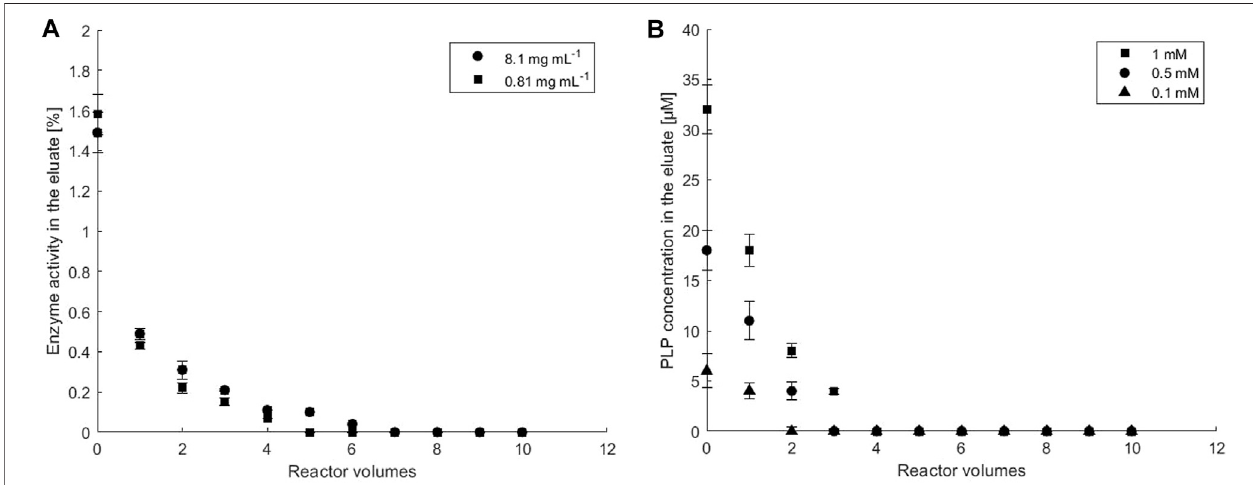
FIGURE 3 | The stability of ATA-v1 and PLP immobilization in a hydrogel embedded in a microbioreactor. (A) Leakage of ATA-v1 from the microreactor at initial enzyme concentration stated in the legend and at 0.1 mM PLP, and (B) leakage of immobilized PLP cofactor from the microreactor at various initial concentrations of immobilizedPLP stated in thelegend, and at 0.81 mg ml − 1 ATA-v1 . The fl ow rate oftheeluent(Hepes buffer, pH 8) was set to50 μ L min − 1 . Errorbars indicate standard deviations of triplicates.